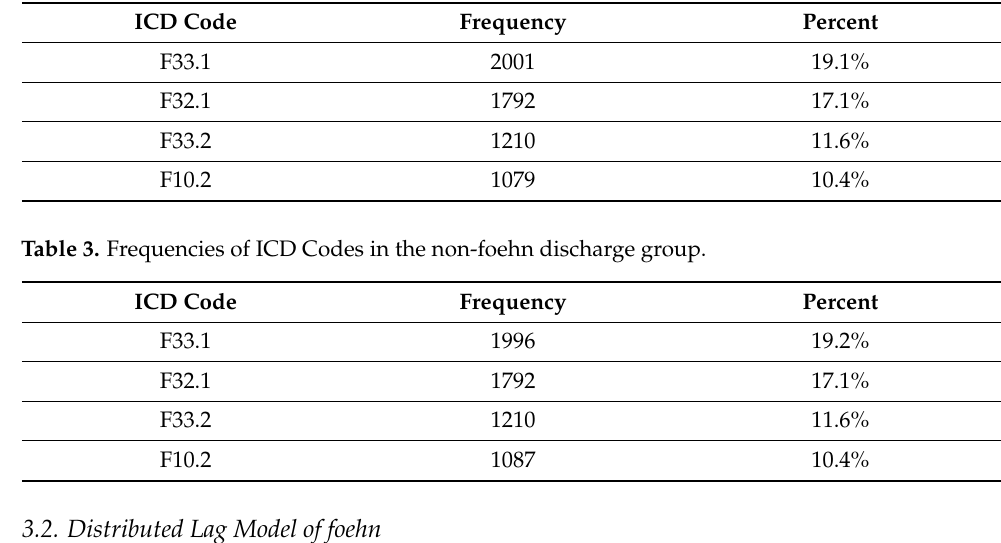
Table 2. Frequencies of ICD Codes in the non-foehn admission group.